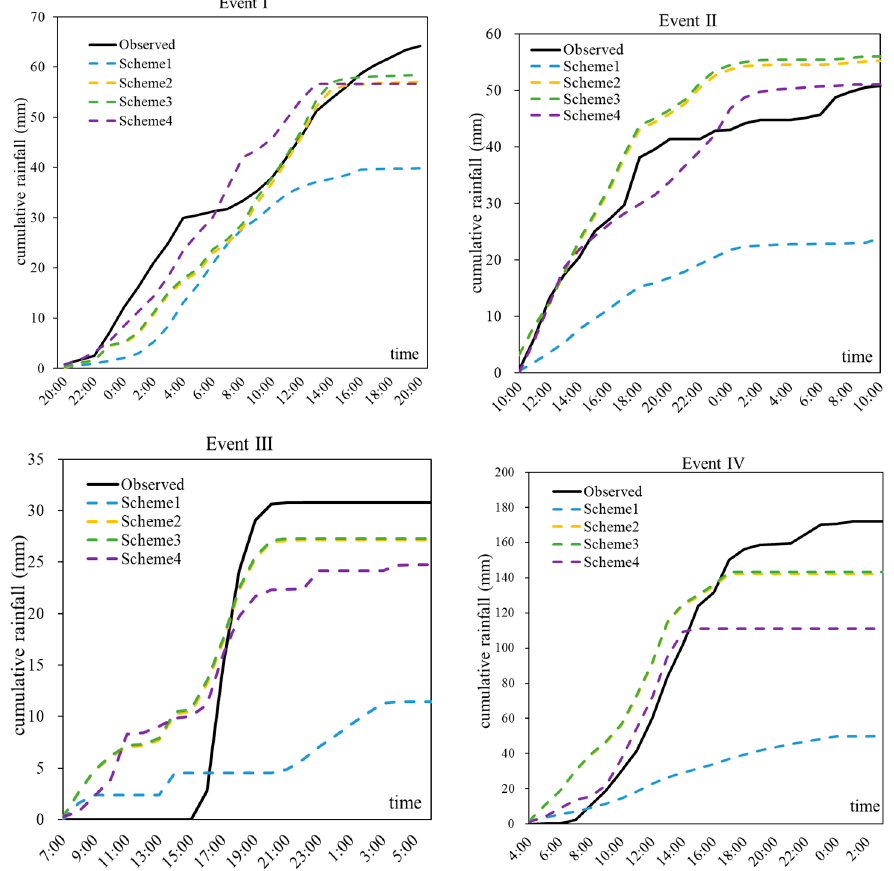
Figure 3. Rainfall accumulation of rain gauge and four data assimilation schemes for Event Ⅰ , Ⅱ , Ⅲ , Ⅳ .